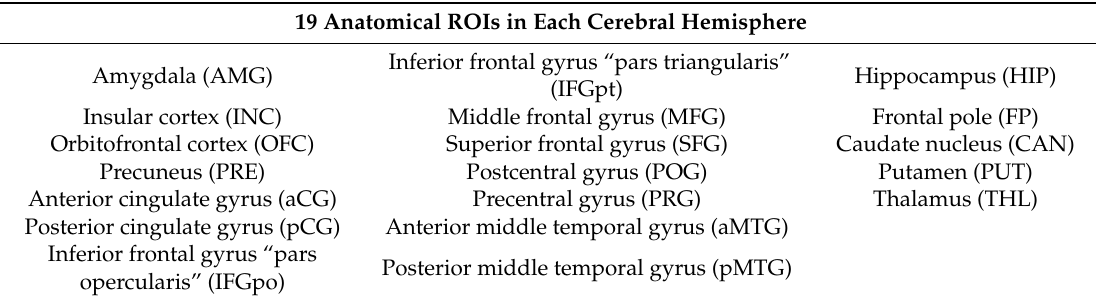
Table 2. Thirty-eight anatomical regions selected for the study (19 regions in each brain hemisphere), part of the default mode network (DMN) and included in the Harvard–Oxford brain